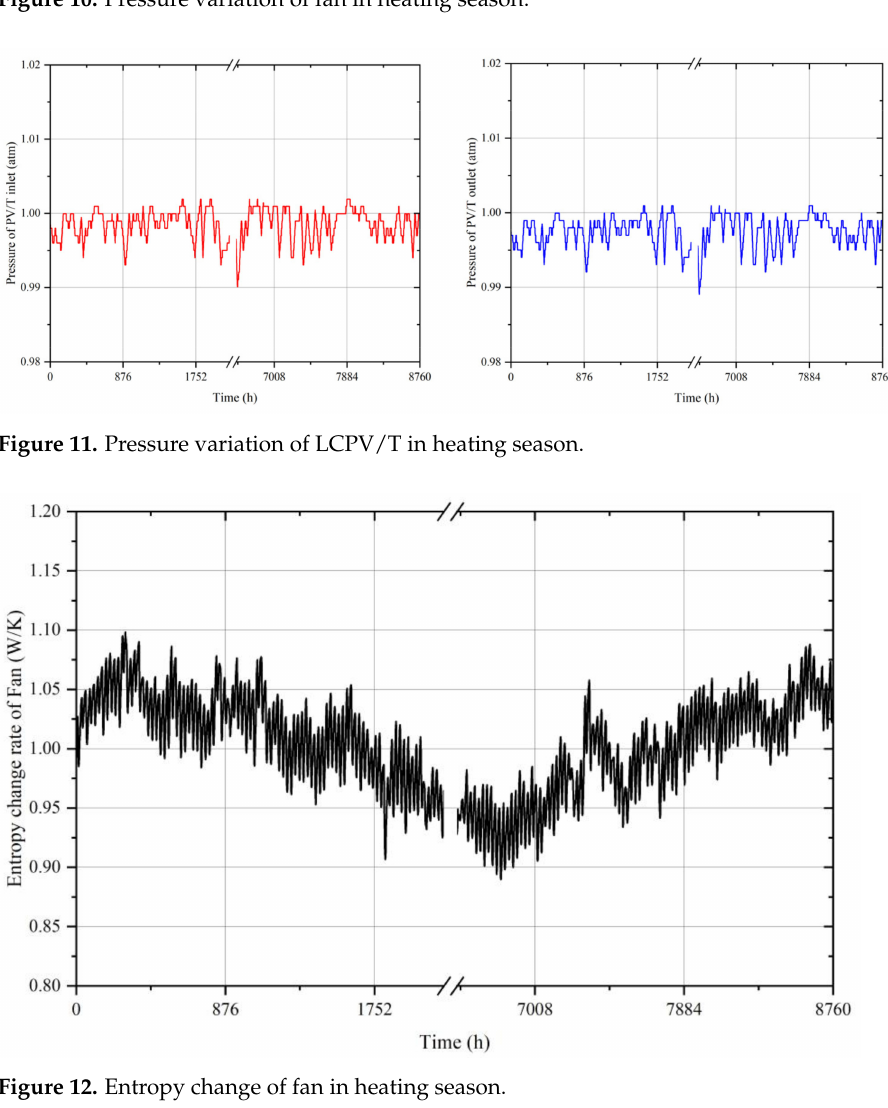
Figure 10. Pressure variation of fan in heating season.